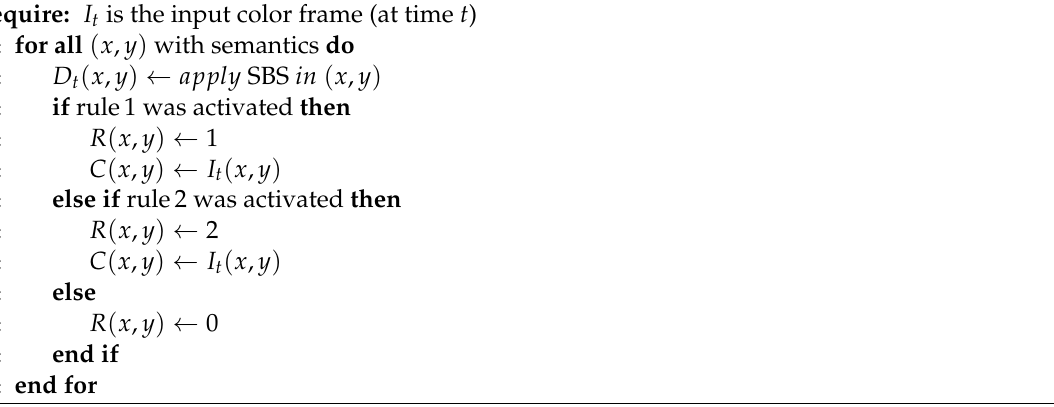
Algorithm 1 Pseudo-code of ASBS for pixels with semantics. The rule and color maps are updated during the application of SBS (note that R is initialized with zero values at the program start).